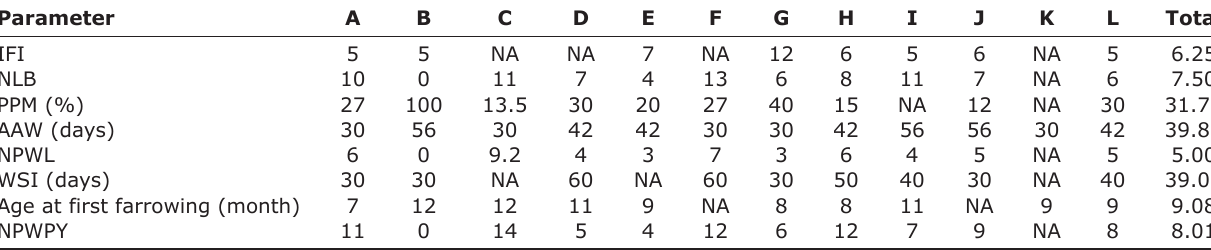
Table-1: Reproductive performance parameters of sow herds in Abuja (herds A-L). Parameter A B C IFI